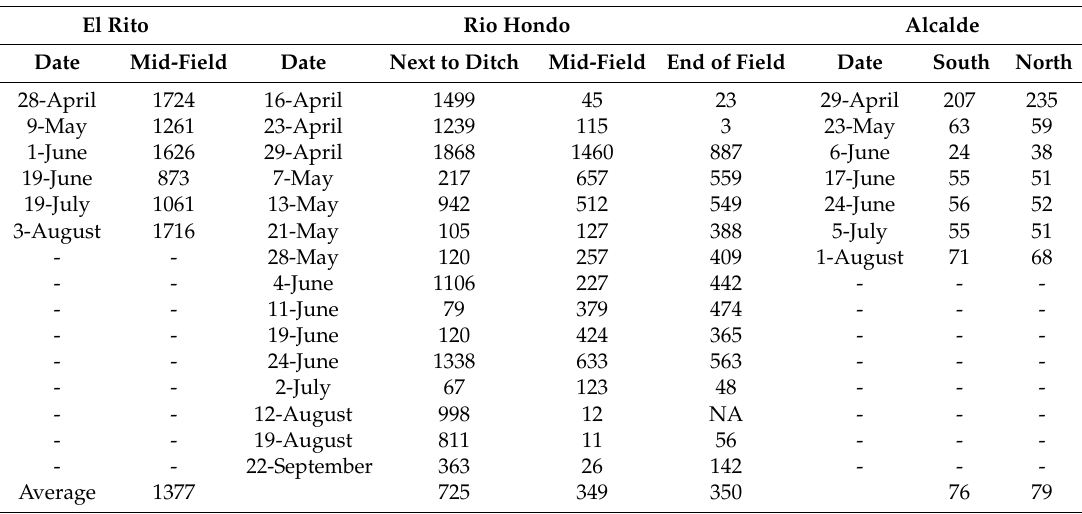
Table 4. Groundwater level rise (mm) in the different field well locations following irrigation for the three study sites, El Rito, Rio Hondo, and Alcalde. El Rito Rio Hondo